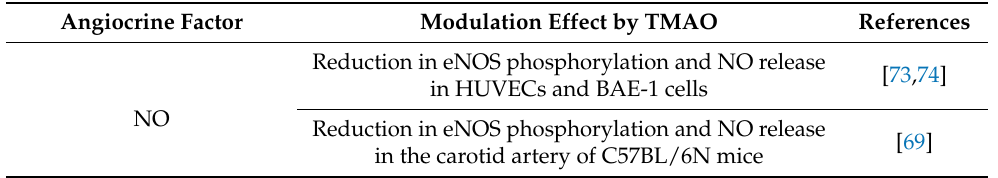
Table 1. TMAO direct modulation of some angiocrine